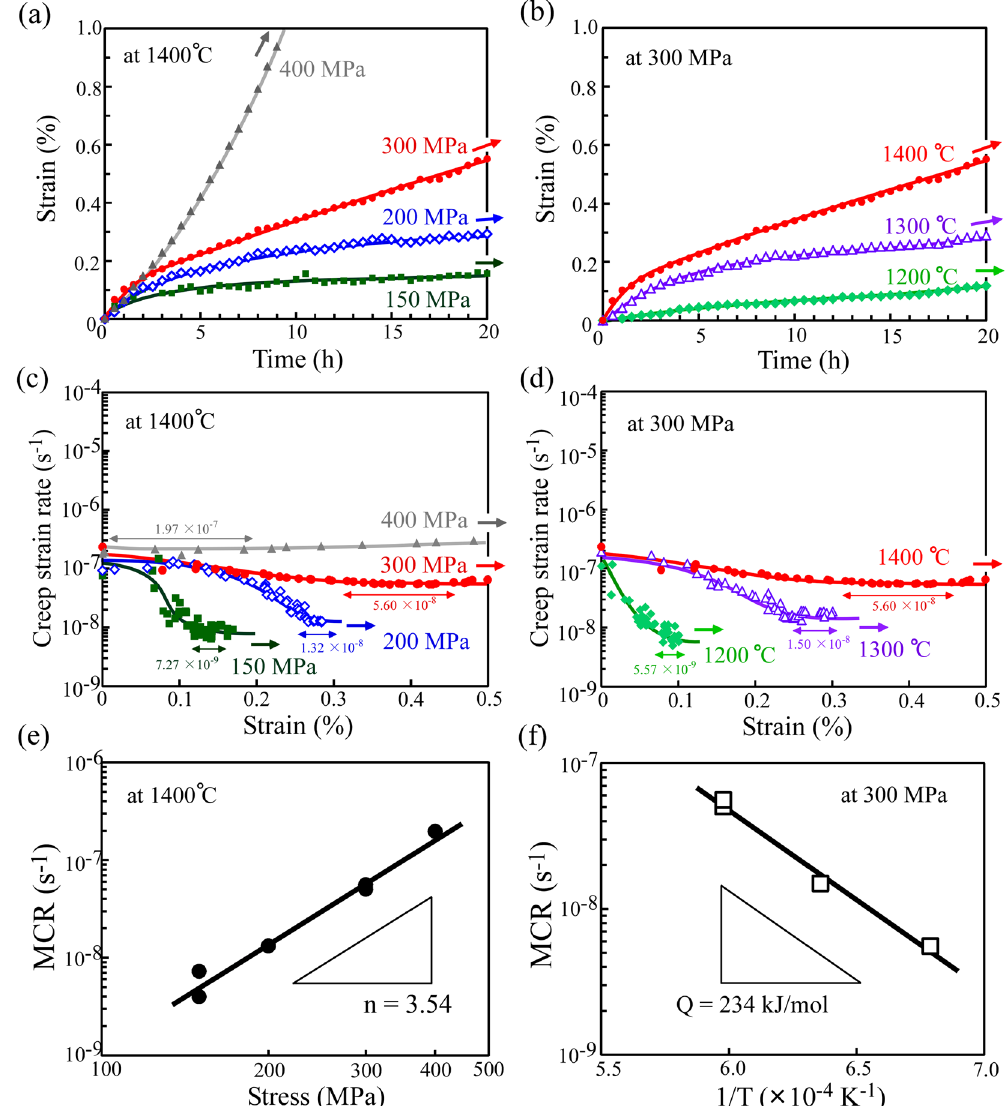
Figure 4. Compressive creep-deformation behavior of the CrIr-added crystals in the 0° orientation. ( a ) Creep strain versus time curves at 1400 °C and 150, 200, 300 and 400 MPa and ( b ) at 300 MPa and 1200, 1300, and 1400 °C. ( c , d ) Corresponding creep strain rate versus strain curves for Figs. ( a , b ), respectively. ( e , f ) Variations in the MCR in the 0° orientation ( e ) at 1400 °C as a function of the applied stress and ( f ) at 300 MPa as a function of the reciprocal of the